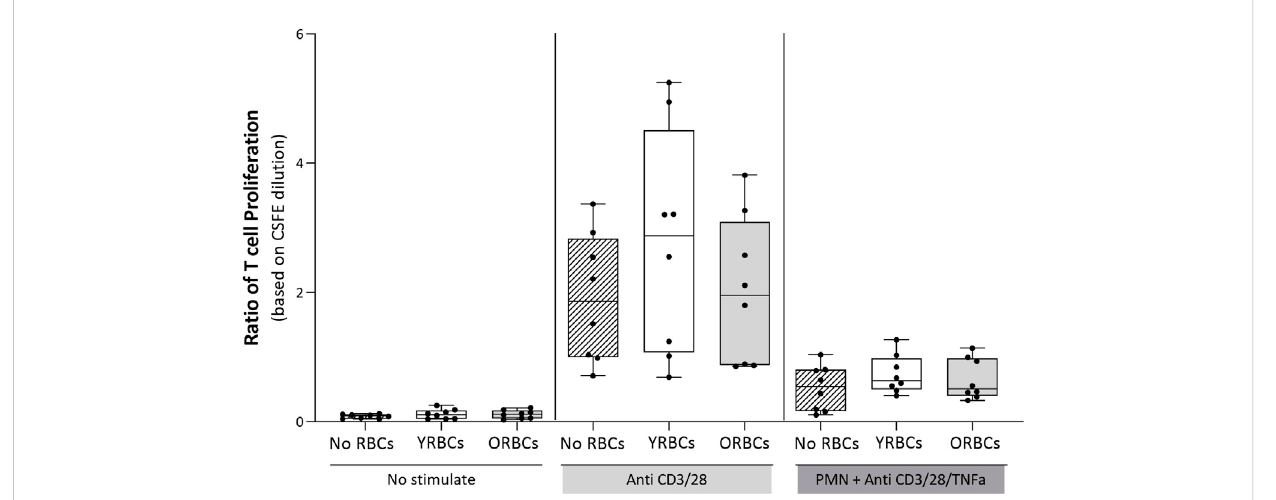
FIGURE 4 The ratio of T cell proliferation. T cells were incubated with young red blood cells (YRBCs) and old red blood cells (ORBCs) in the presence or absence of the stimulus (anti-CD3 and anti-CD28). T cell proliferation was suppressed with polymorphonuclear neutrophils (PMNs) in the presence of anti-CD3, anti-CD28, and TNF α . n = 8